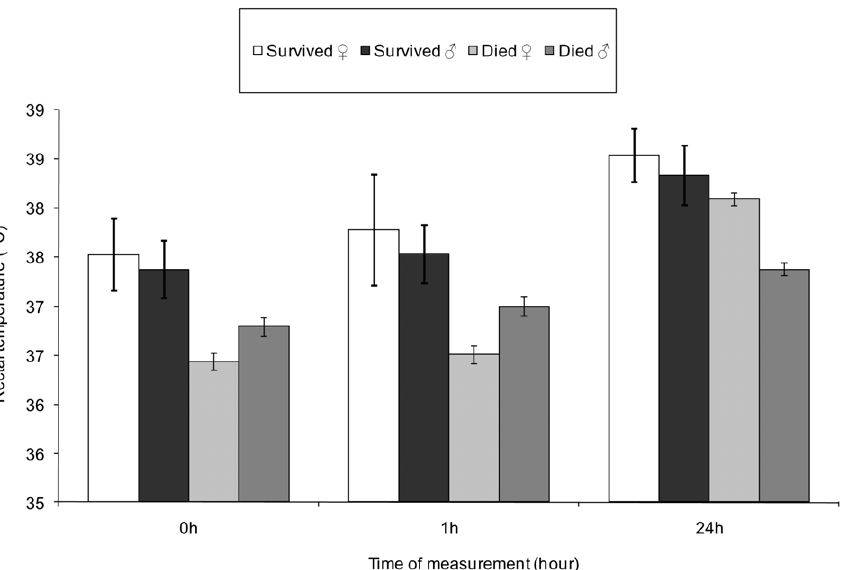
Figure 2. Plot of mean rectal temperatures ( ± SE) illustrating temperatures at birth, 1 h after birth and 24 h after birth between females ( R ) and males ( = ) that survived to weaning (Survived) and those that died before weaning (Died).